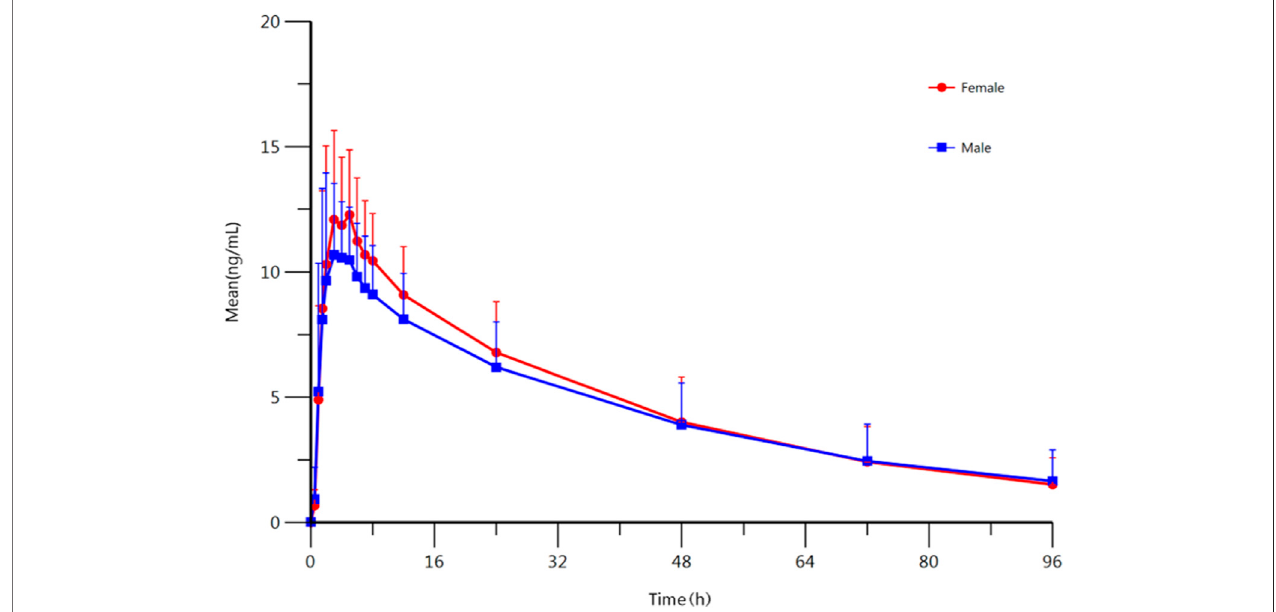
FIGURE 1 | Mean plasma concentration-time pro fi le of escitalopram after oral administration of 10 mg escitalopram tablet in males ( n (cid:1) 67) and females ( n (cid:1) 23), respectively. All values are presented as mean ± standard deviation.